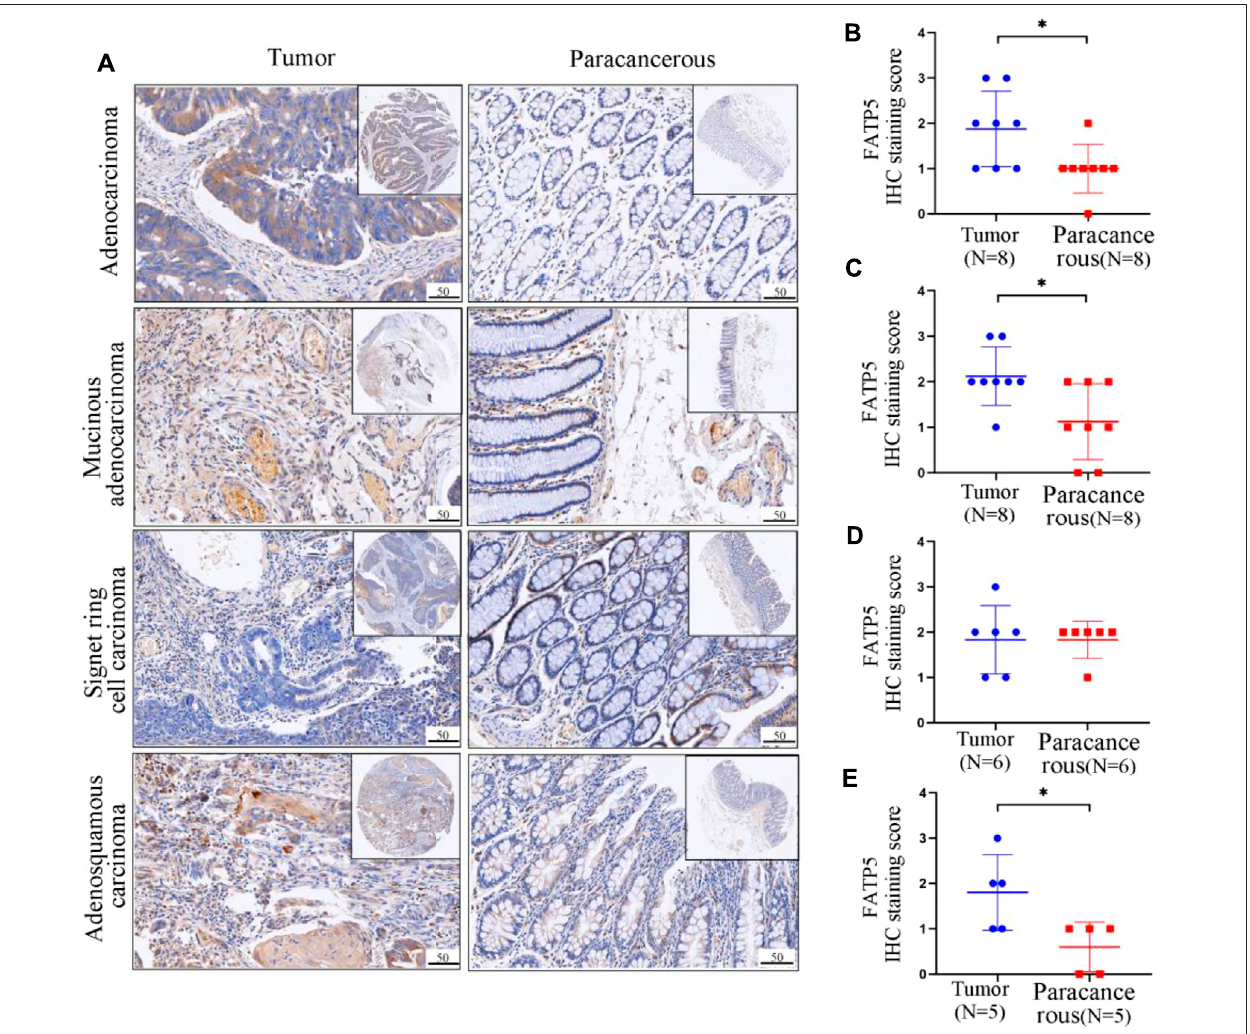
FIGURE 7 | Representative IHC staining and quantitative analysis showing the expression of FATP5 in colorectal tumors and adjacent tumor tissues. (A) IHC staining of tumour tissues and paracancerous tissues. The protein expression levels of FATP5 in adenocarcinoma (B) , Mucinous. adenocarcinoma (C) , Signet ring cell carcinoma (D) and Adenosquamous carcinoma (E) . ** p <